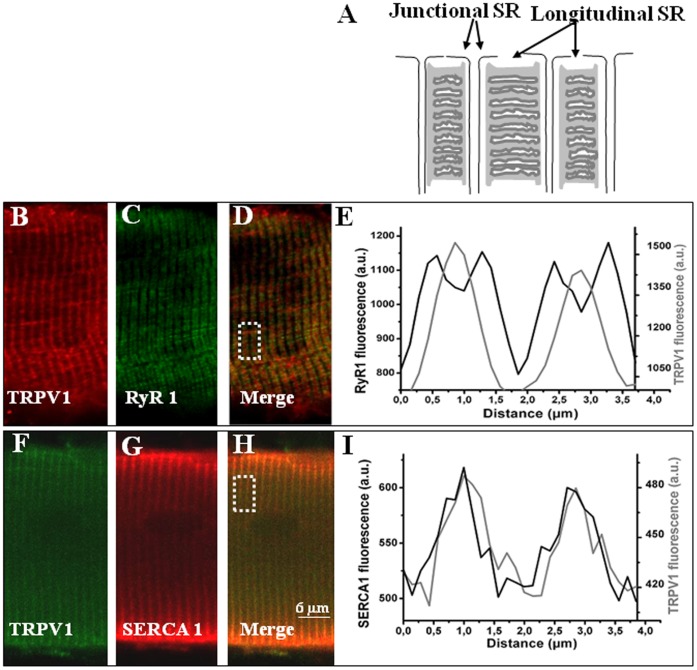
Localization of TRPV1, RyR1 and SERCA1 in mouse FDB fibers.A: Schematic organization of the sarcoplasmic reticulum (SR) in a skeletal muscle fiber. Confocal images of double immunofluorescence labeling of TRPV1 (B) and RyR1 (C) or TRPV1 (F) and SERCA1 (G). E, I: average intensity profiles from the dotted rectangle region in the next corresponding images. In isolated fibers, RyR1 shows localization in the junctional part of the SR (C) while SERCA1 appears in the longitudinal part of the SR (G). In the merged images, TRPV1 does not colocalize with RyR1 (D) while colocalization with SERCA1 staining is visible in H. Results are from at least 4 independent fibers preparations (n>10).